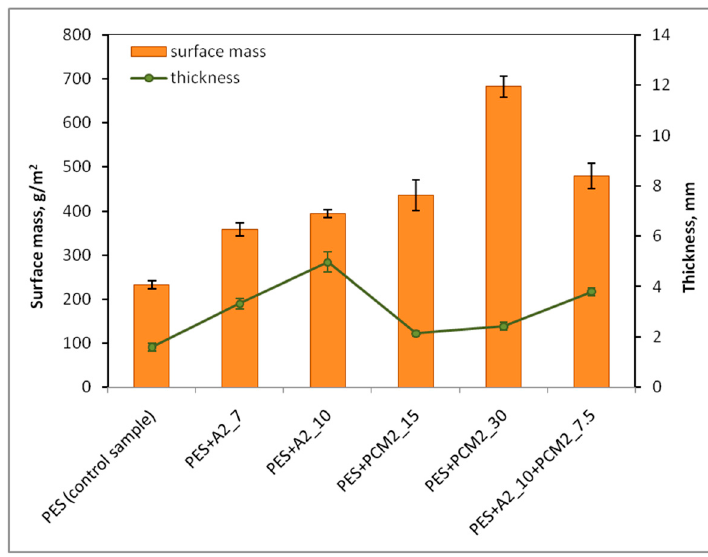
Figure 3. Thickness and surface mass of the nonwoven